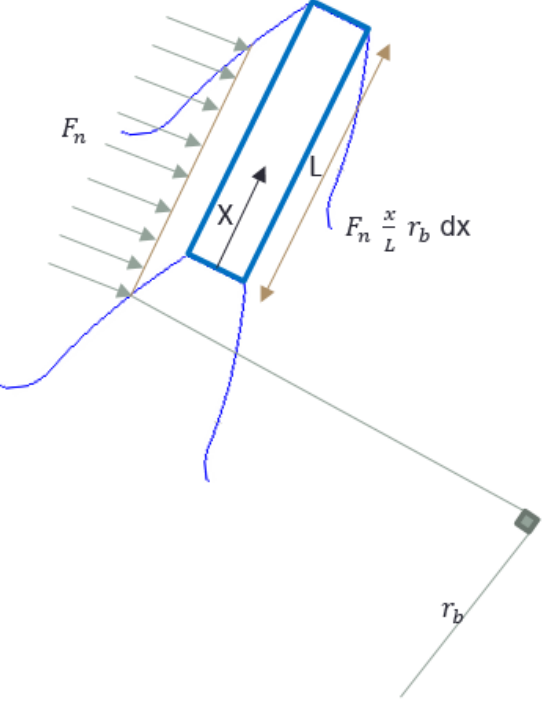
Figure 8. Finding the torsional deformation in the RZ direction with uniform loading.